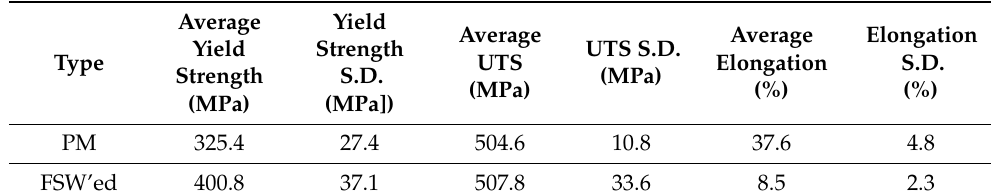
Figure 7. Stress–strain curves of: ( a ) parent-metal specimen; ( b ) friction-stir-welded specimen. Table 3. Tensile-test results.